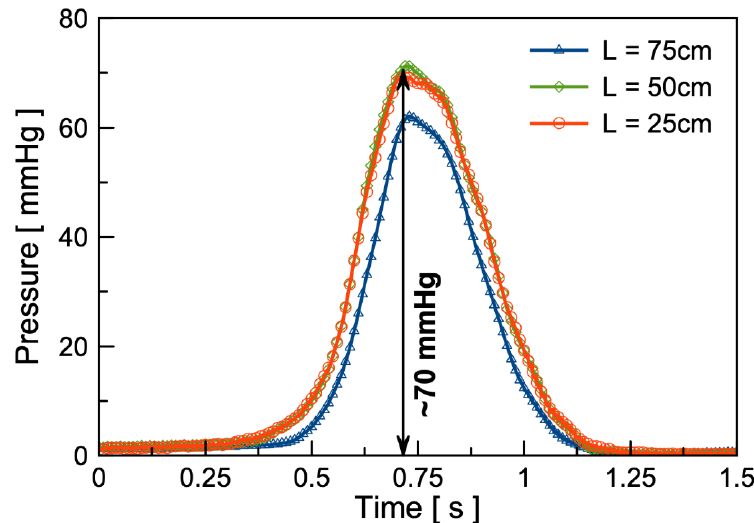
Figure 5. Ex vivo dynamic pressure response of the microfluidic pump connected to PE90 tubes 75 cm, 50 cm, and 25 cm in length using 0.9% heparinized saline. The external magnet used is a NdFeB magnet with a diameter of 38.1 mm and 12.7 mm thick operated at distance ranging from 15 mm to 85